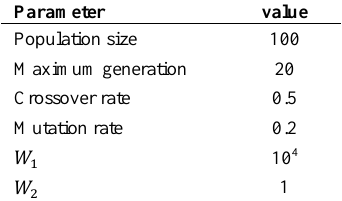
Figure 3. Identification block diagram with input selection by GA. Table 3. Parameters used in